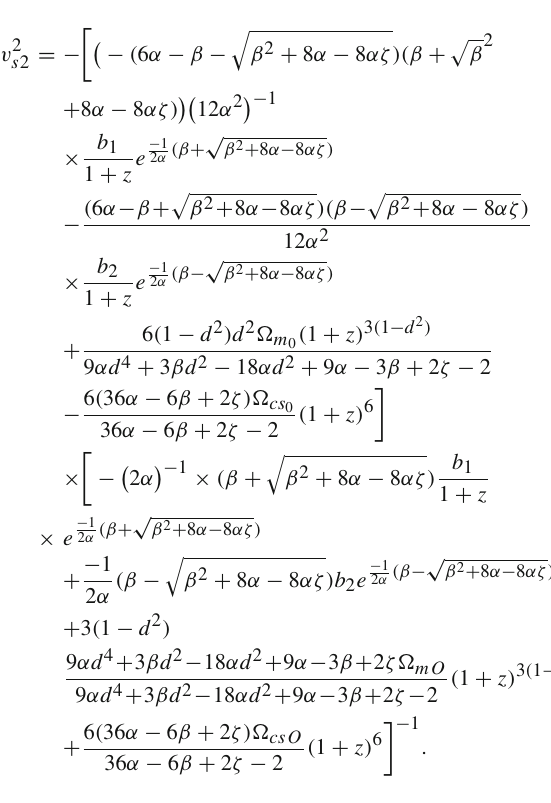
Itsworkingmethodologydependsuponthedensityoftheper- turbation theory from the theory of linear perturbation [92].